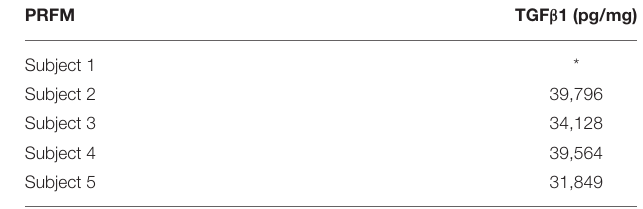
TABLE 3 | Average fibrin size and platelet diameter in PRFM analyzed through SEM.